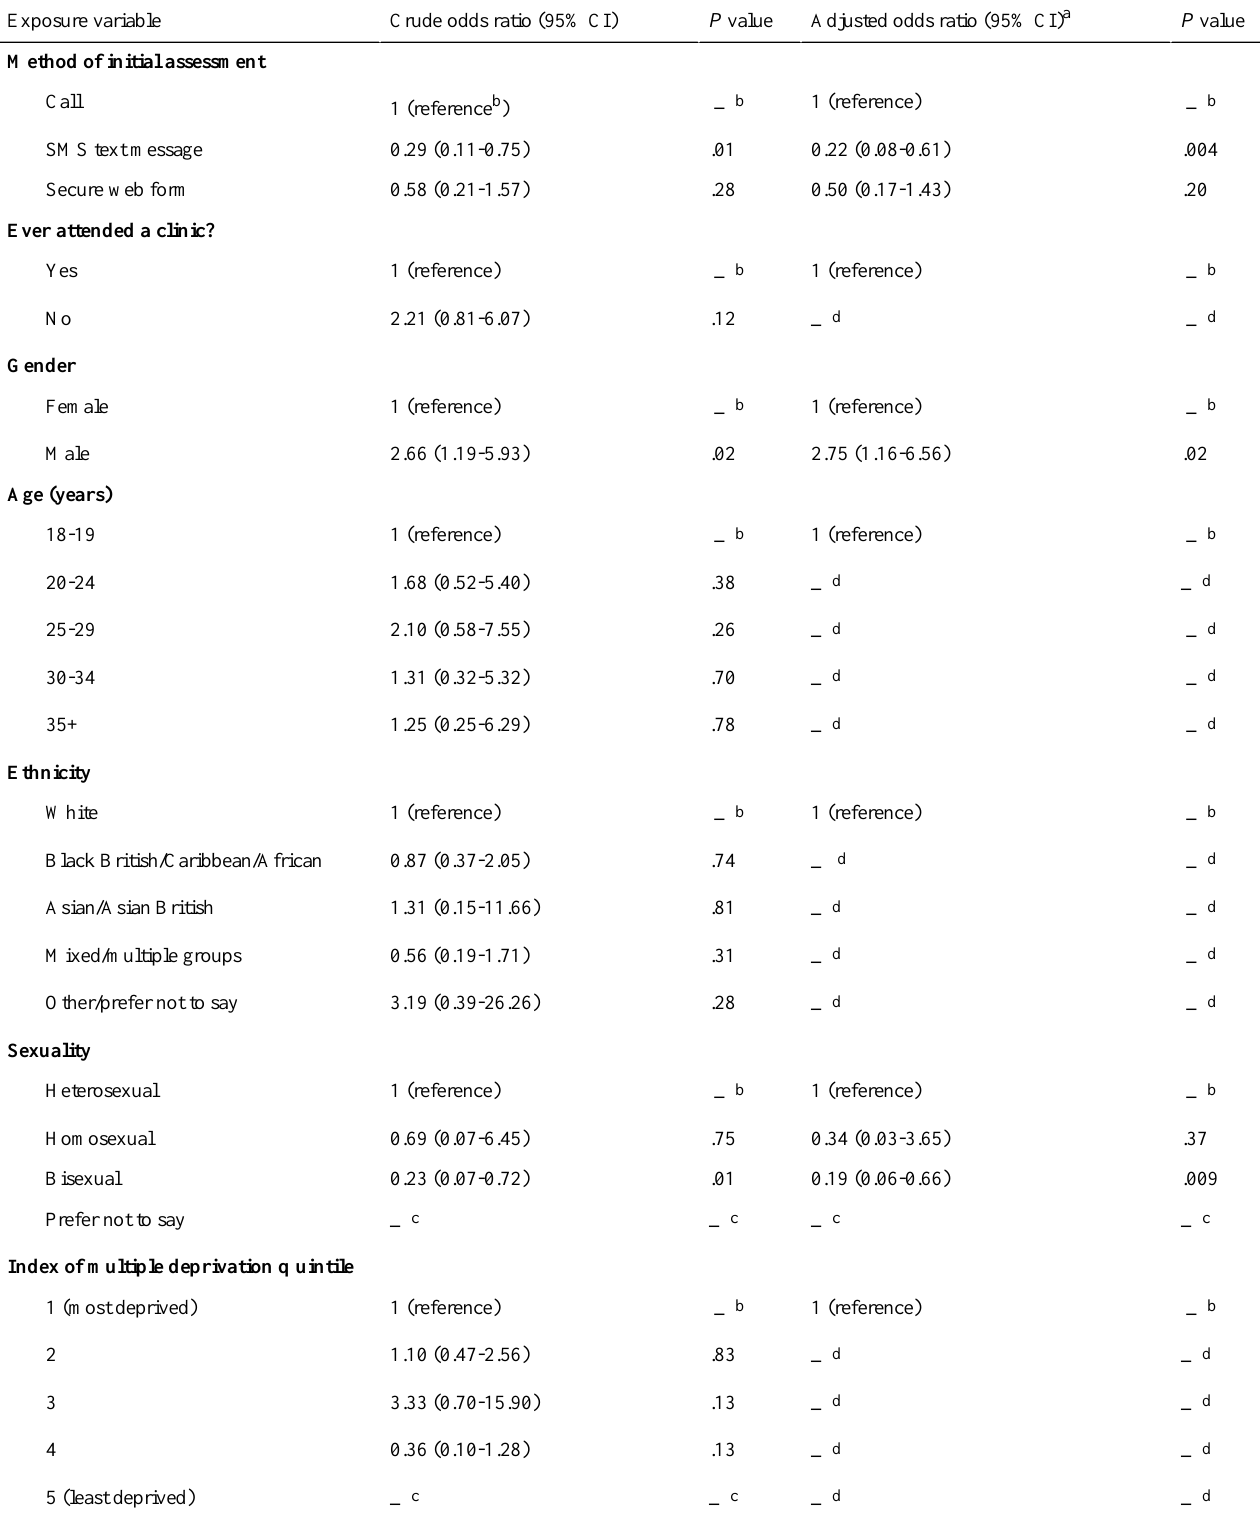
Table 2. Crude and adjusted odd ratios of agreement in reporting